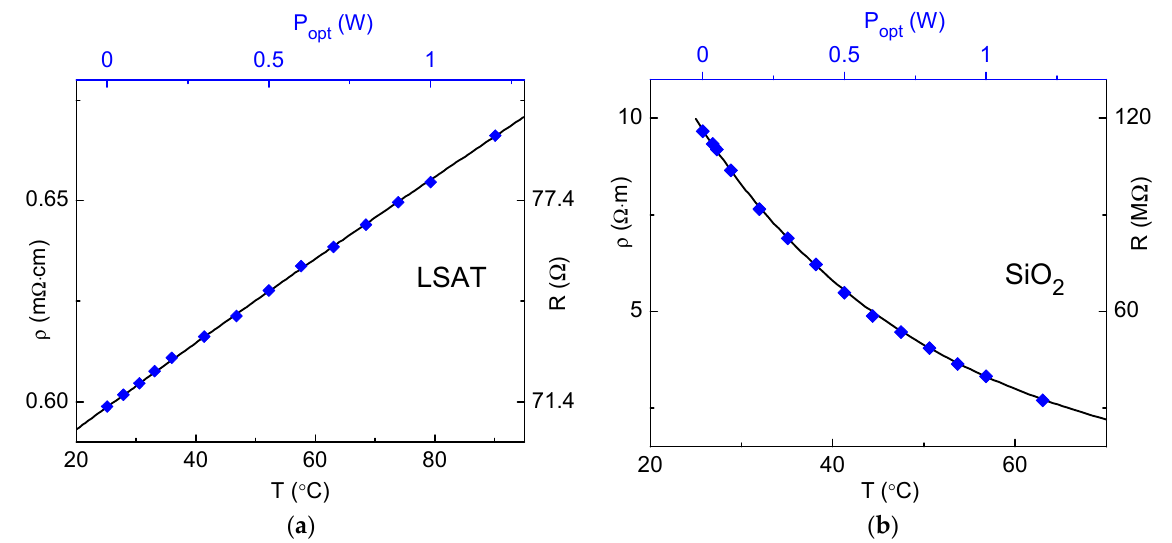
Figure 5. Change of the resistivity with optical power of the blue laser superimposed on the corresponding temperature dependence for NNO films on ( a ) LSAT and ( b ) SiO 2 substrates. The right ordinate axes indicate the corresponding resistance values. The temperature controller holds T = 26 °C.